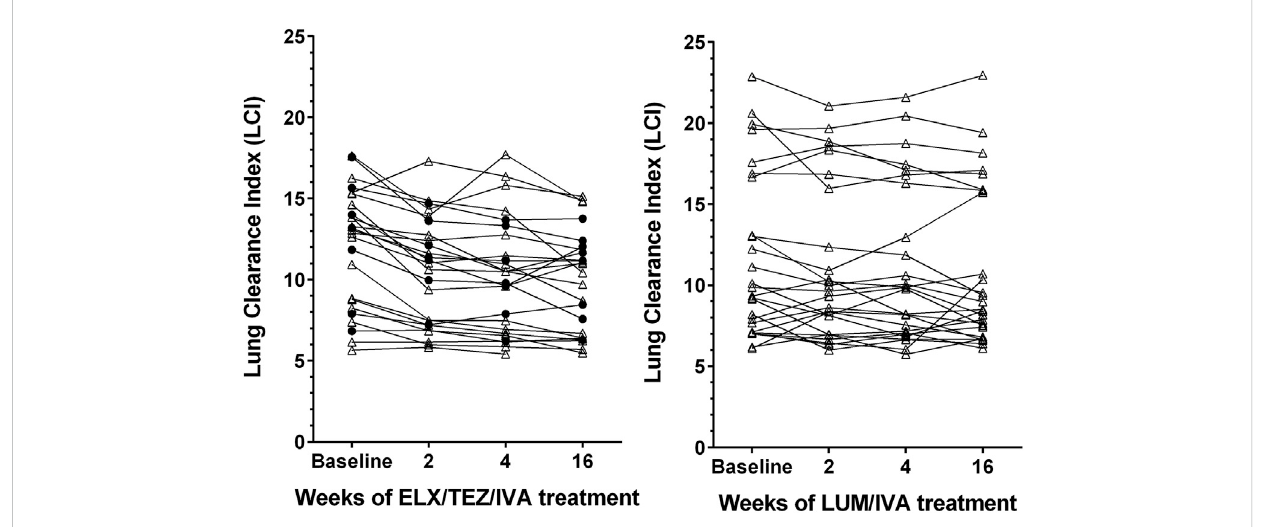
FIGURE 1 Line graphs depicting lung clearance index (LCI) in patients with cystic fi brosis after treatment with elexacaftor/tezacaftor/ivacaftor (left side, ELX/ TEZ/IVA; n =25)andlumacaftor/ivacaftor(rightside,LUM/IVA; n =26).Filledcirclesdenotemeasurementsinpatientspretreatedwithanothermodulator, triangles denote measurements in patients who were modulator naïve before receiving ELX/TEZ/IVA.